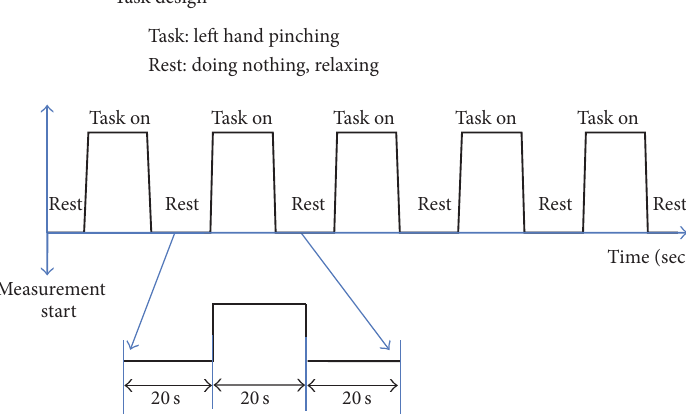
Figure 6: The procedure of the pinching task. The patient was instructed to relax for 10s, and then the operator ordered the patient to start pinching with the left thumb and index finger every 2s at the operator’s command. After 20 s of pinching, the patient was instructed to relax for another 10s: 5 cycles of 10s rest, 20 s pinching task, and 10s rest were performed for averaging. Therefore, there is an interval of 20s between 2 pinching tasks.